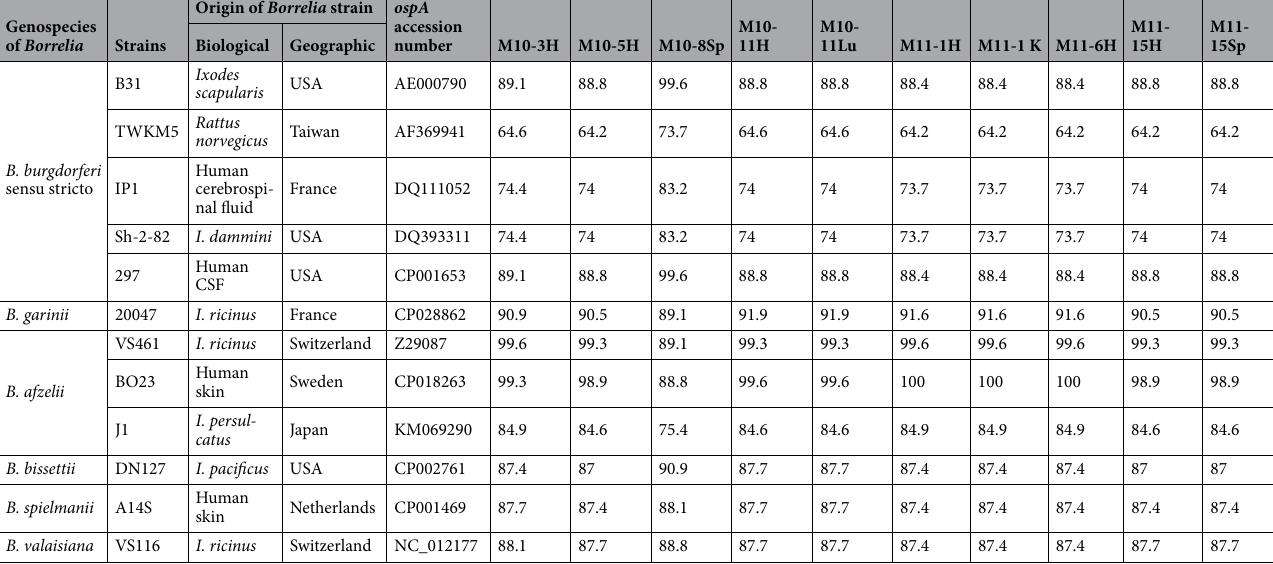
Table 3. Similarity between Borrelia ospA gene sequences from GenBank and wild rodents captured in this study † . † ospA , outer surface protein